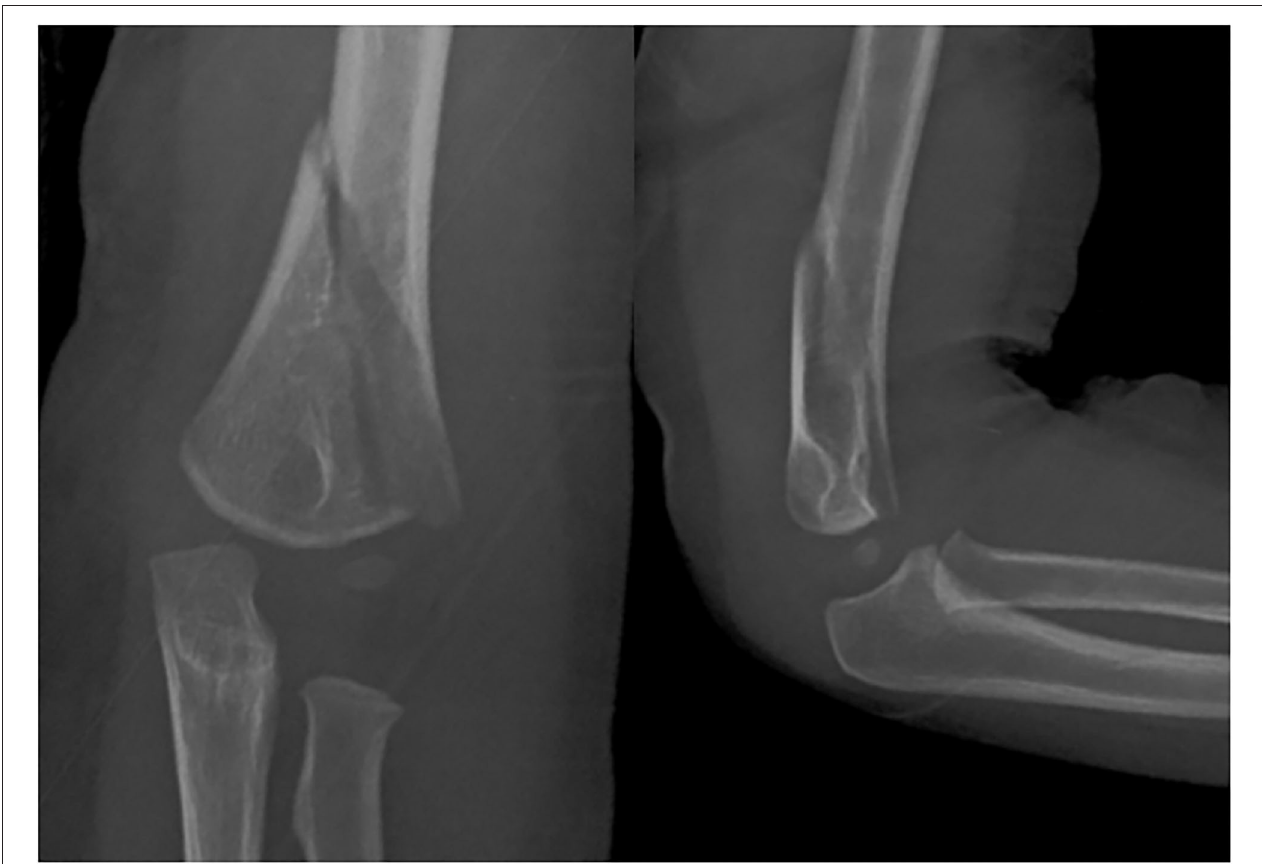
FIGURE 2 | A 2-year-old child fell from the bed and had a direct contact injury to the left elbow. The radiographs demonstrate a completely displaced medial high-long oblique supracondylar humeral